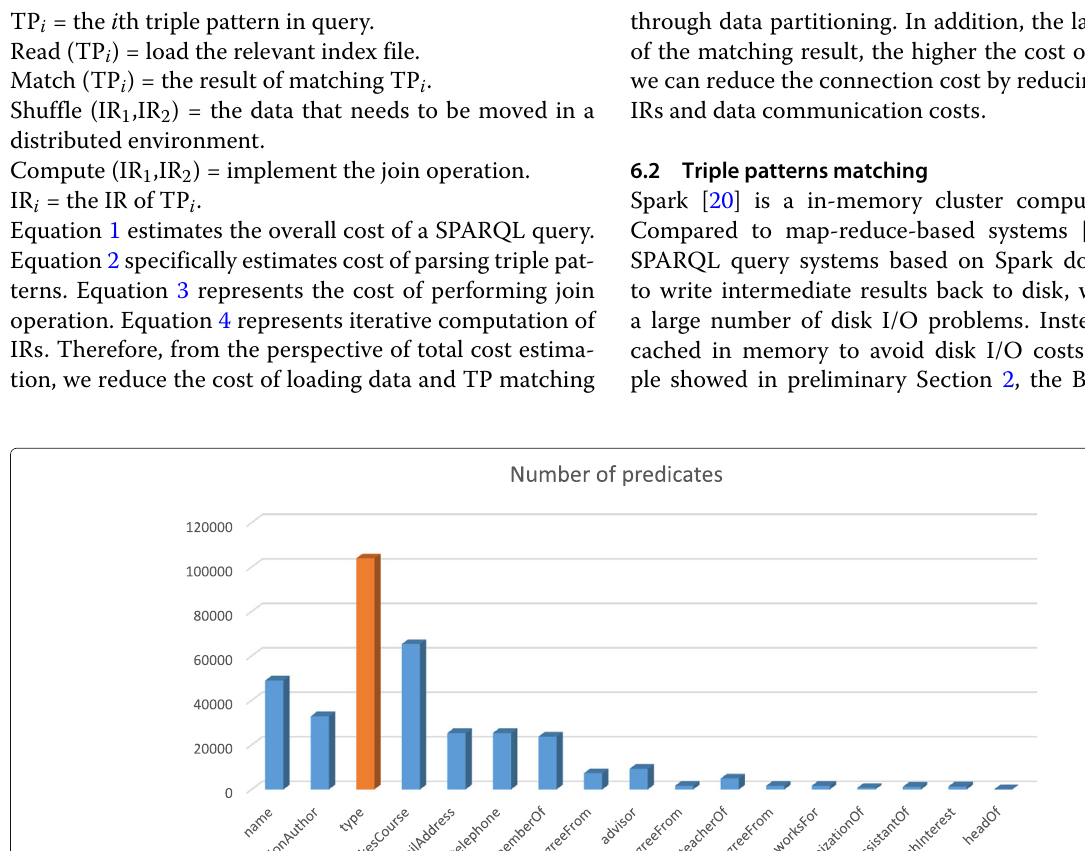
TP i = the i th triple pattern in query. Read (TP i ) = load the relevant index file.